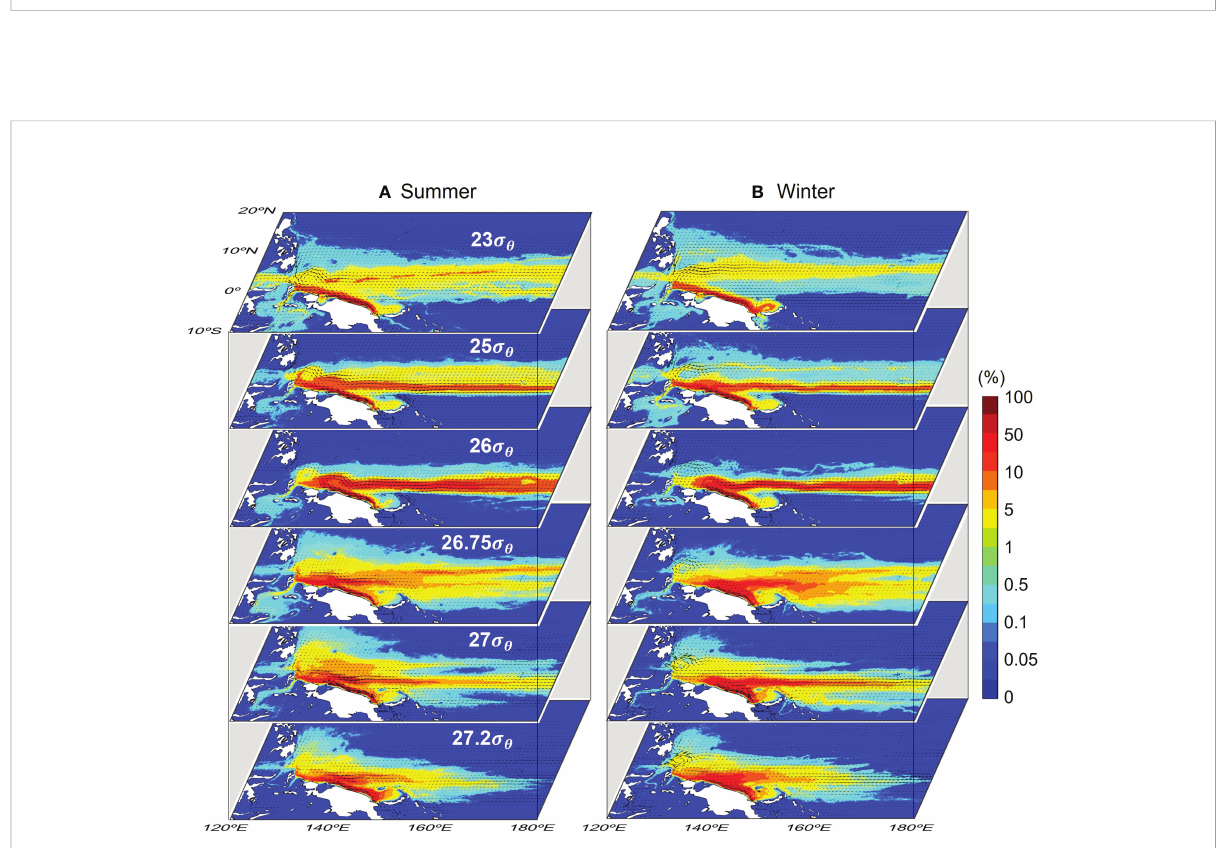
FIGURE 9 Composite map of mean probability distribution of NGCUC water parcels (%) at the isopycnal layers of 23, 25, 26, 26.75, 27, and 27.2 s q . The probability at each layer was estimated from 50 tracers that were released around NGCUC region every day during (A) Summer and (B) Winter phases from 1994 to 2013 with the travel time of two years. The black arrows indicate current vectors.